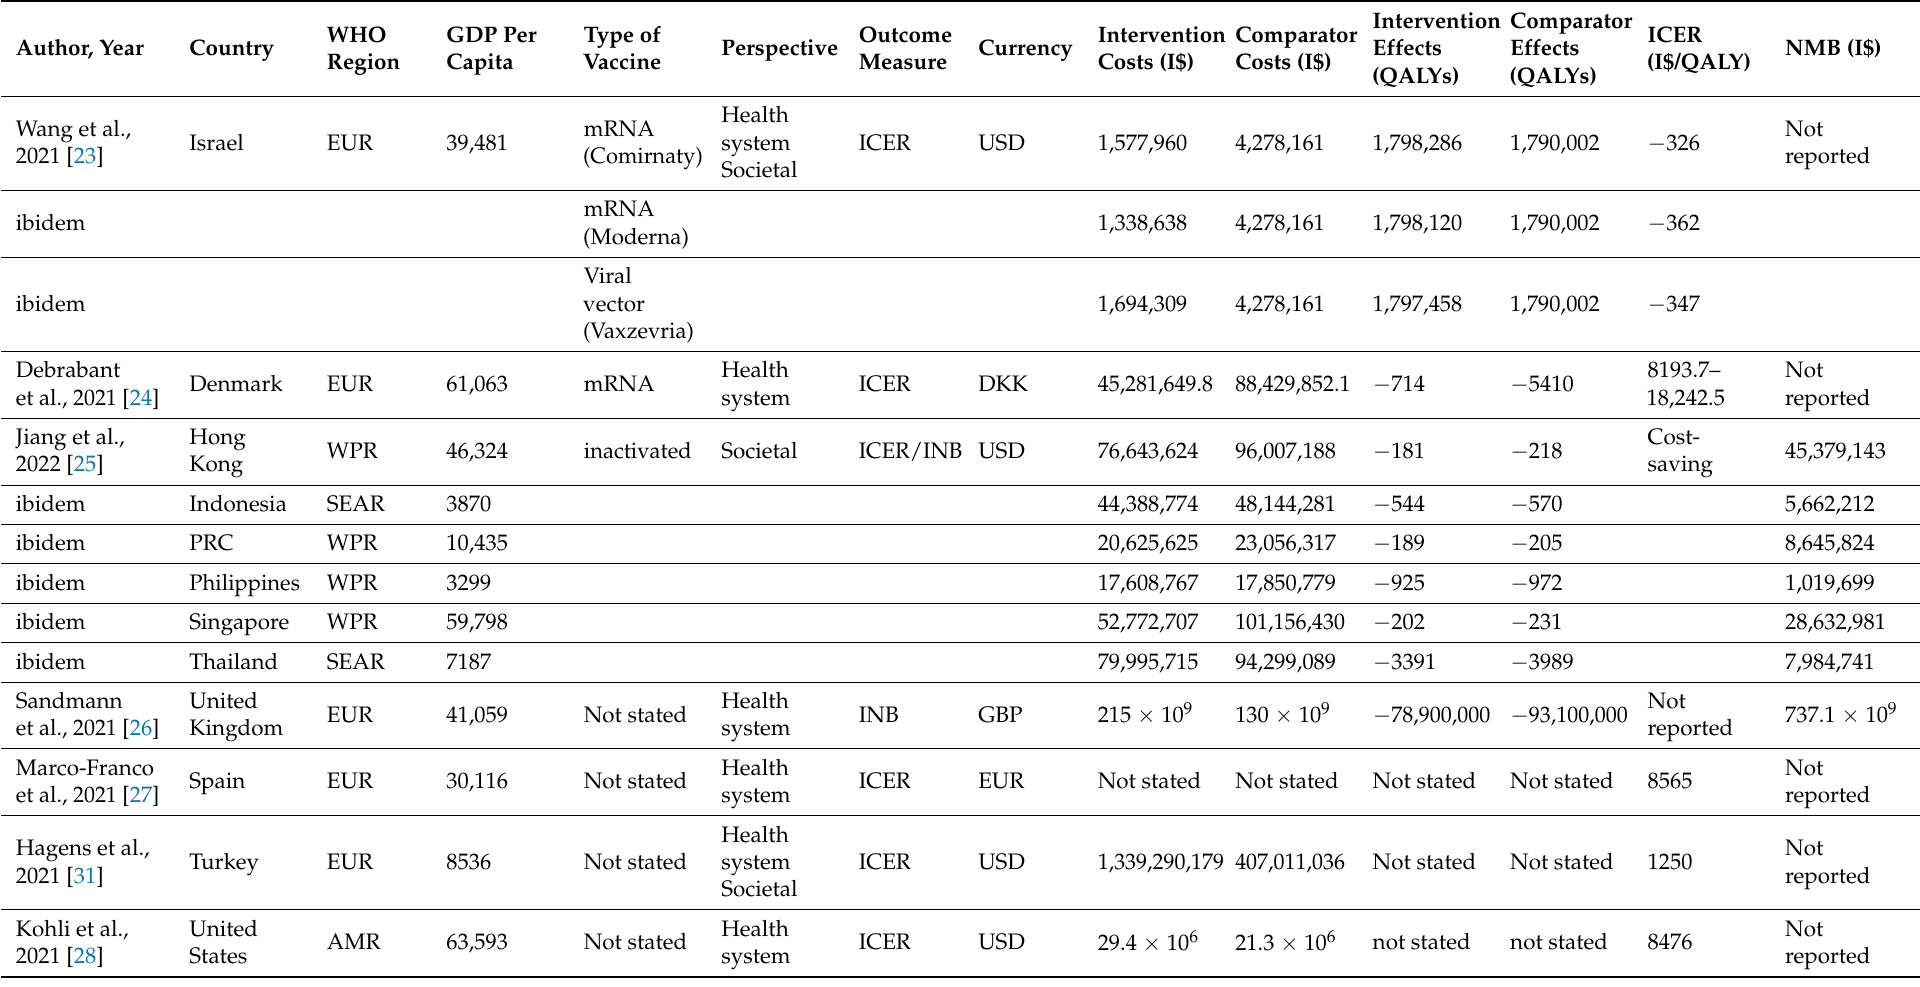
Table 1. Additional study characteristics. Abbreviations: USD (United States dollar), DKK (Danish Krone), EUR (euro), CAD (Canadian dollar), ICER (incremental cost-effectiveness ratio), NMB (net monetary